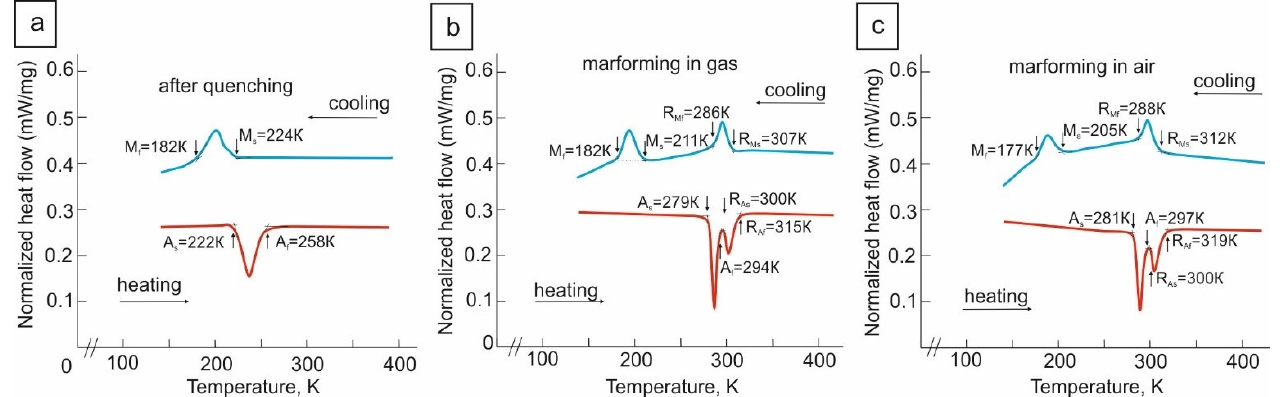
Figure 2. DSC curves of the [011]-oriented Ti-50.1Ni single crystals: ( a ) after quenching; ( b ) after annealing at 713 K for 0.5 h in helium gas; ( c ) after annealing at 713 K for 0.5 h in dry air.